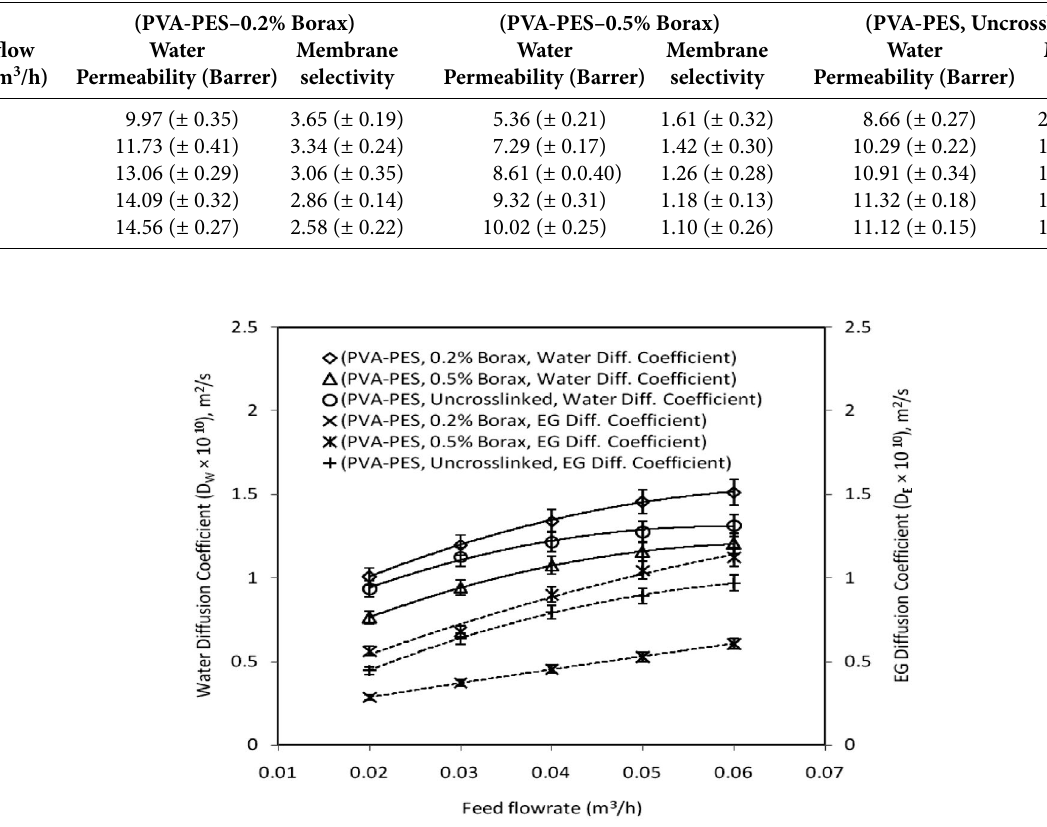
Table 4. Water permeability and selectivity of the membranes used in the present study as a function of feed flow rate. (Each experimental data point is the average of three readings; the figures in the bracket from column 2 to column 7 indicate standard deviation.)